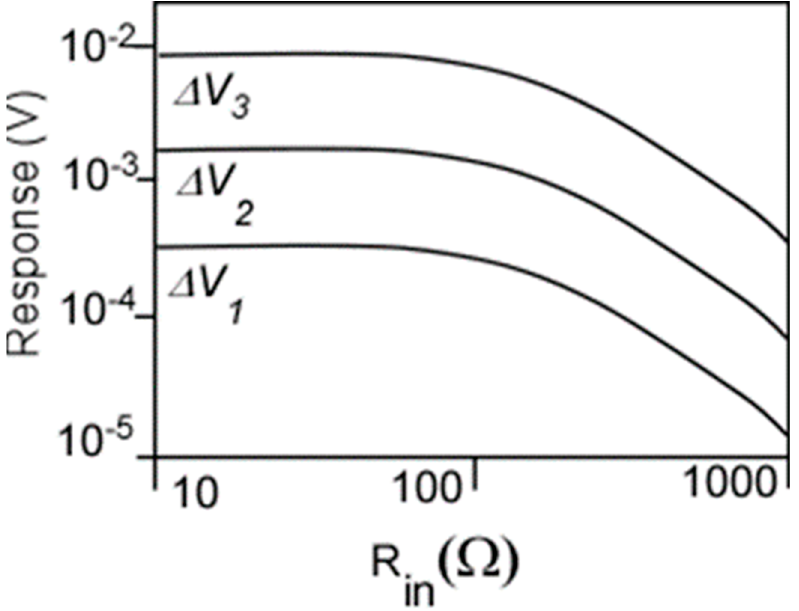
Figure 10. Drain response for each stage using harmonic balance (HB) and transient simulation as a function of the THz signal impedance with different schemes and approaches. Δ U 1 , Δ U 2 , and Δ U 3 are the response at V d1 , V d2 , and V d3 , respectively (see Figure 9).